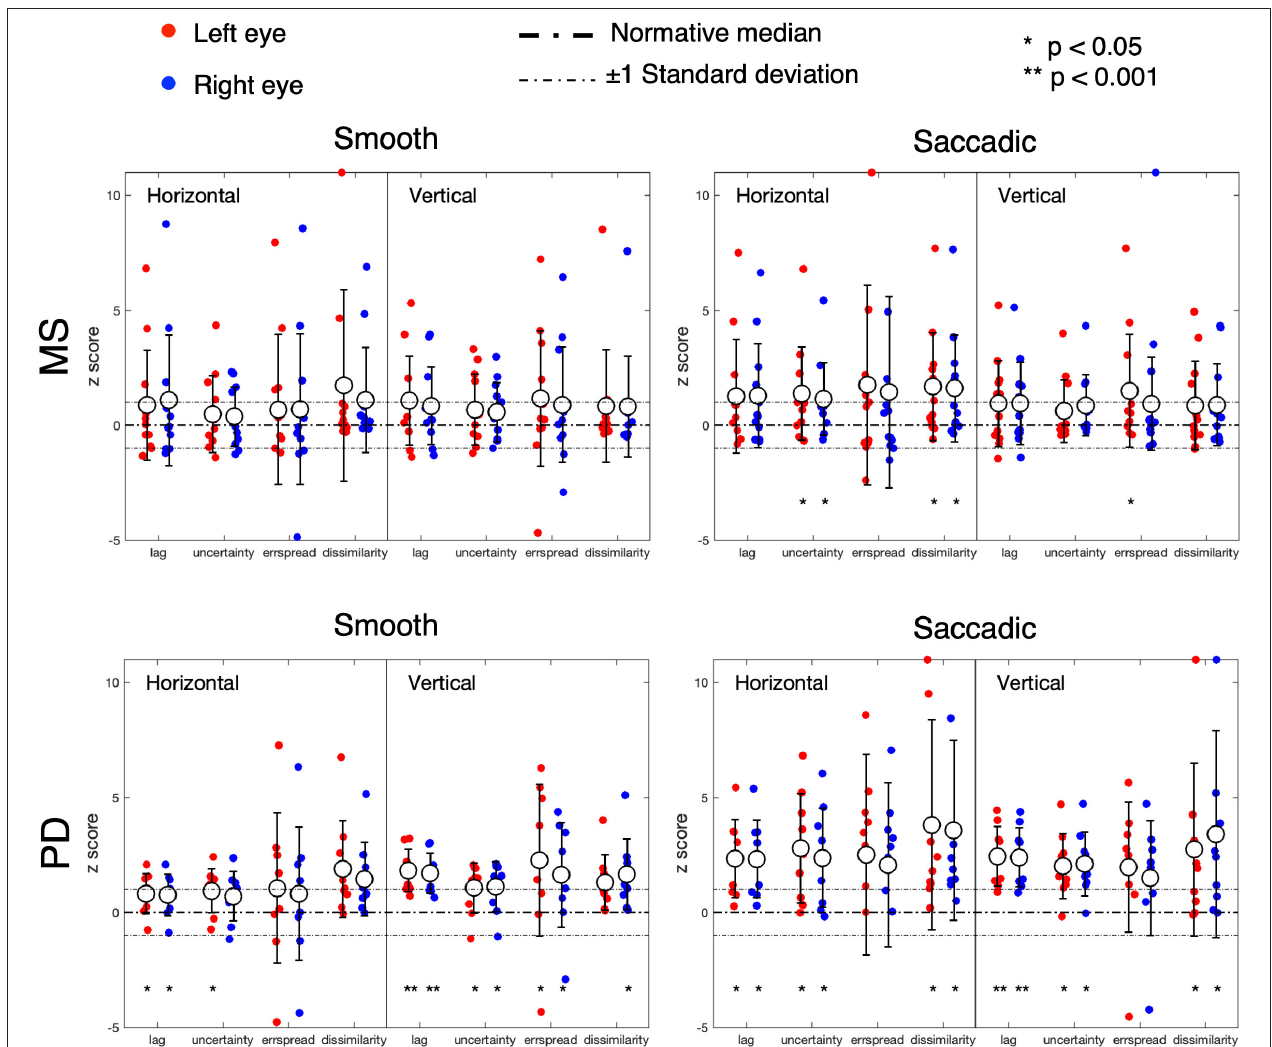
FIGURE 3 | Oculomotor spatio-temporal properties in MS and PD cohorts, compared to an age-matched normative baseline. For the spatio-temporal analysis of the continuous gaze tracking task, we applied the eye-movement crosscorrelogram method ( 13, 14). From all features computed, we selected the two temporal and two spatial features that were shown to be most strongly modulated by stimulus velocity (30). The selected features are: “ lag ” (F1), “ temporal uncertainty ” (F2), “ error spread ” (F3), and “ dissimilarity ” (F4). “Lag” represents the delay between eyes and stimulus, measured as the temporal offset of the peak of the cross-correlation between stimulus and eye velocities. “Temporal uncertainty” represents the consistency of the velocity of the eye in relation to the velocity of the stimulus. “Error spread” is the standard deviation of the distribution of eye-stimulus positional deviations. “Dissimilarity” is the inverse of the cosine similarity computed between the arrays of gaze coordinates and stimulus